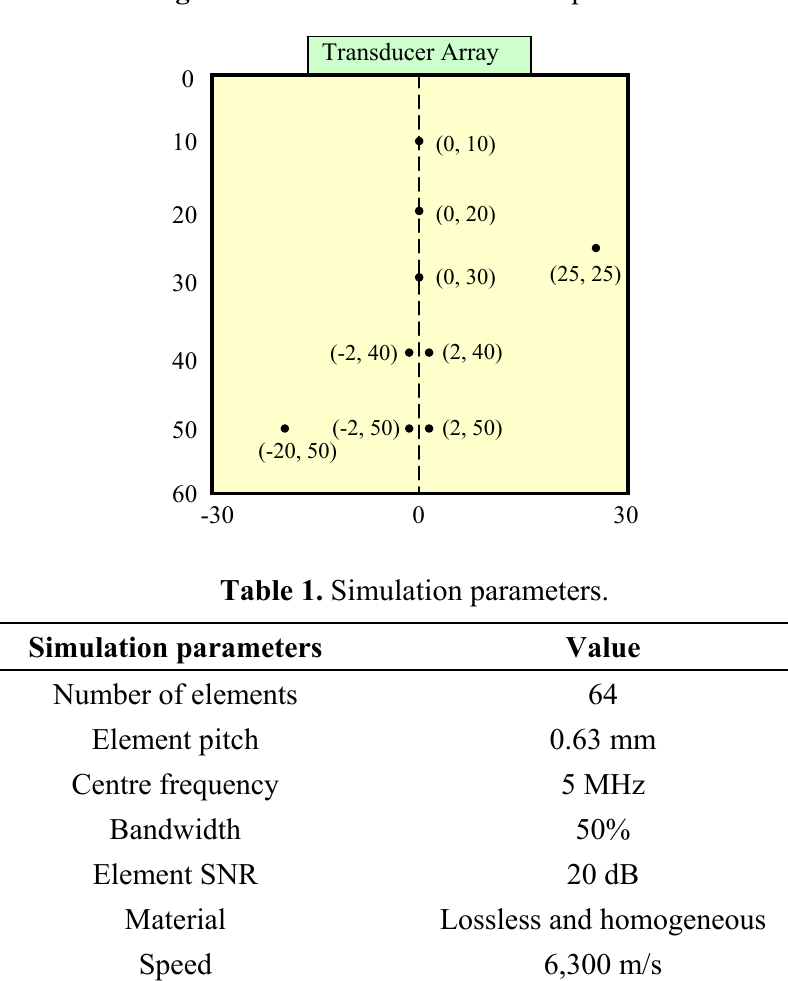
Figure 3. Schematic of simulated specimen.